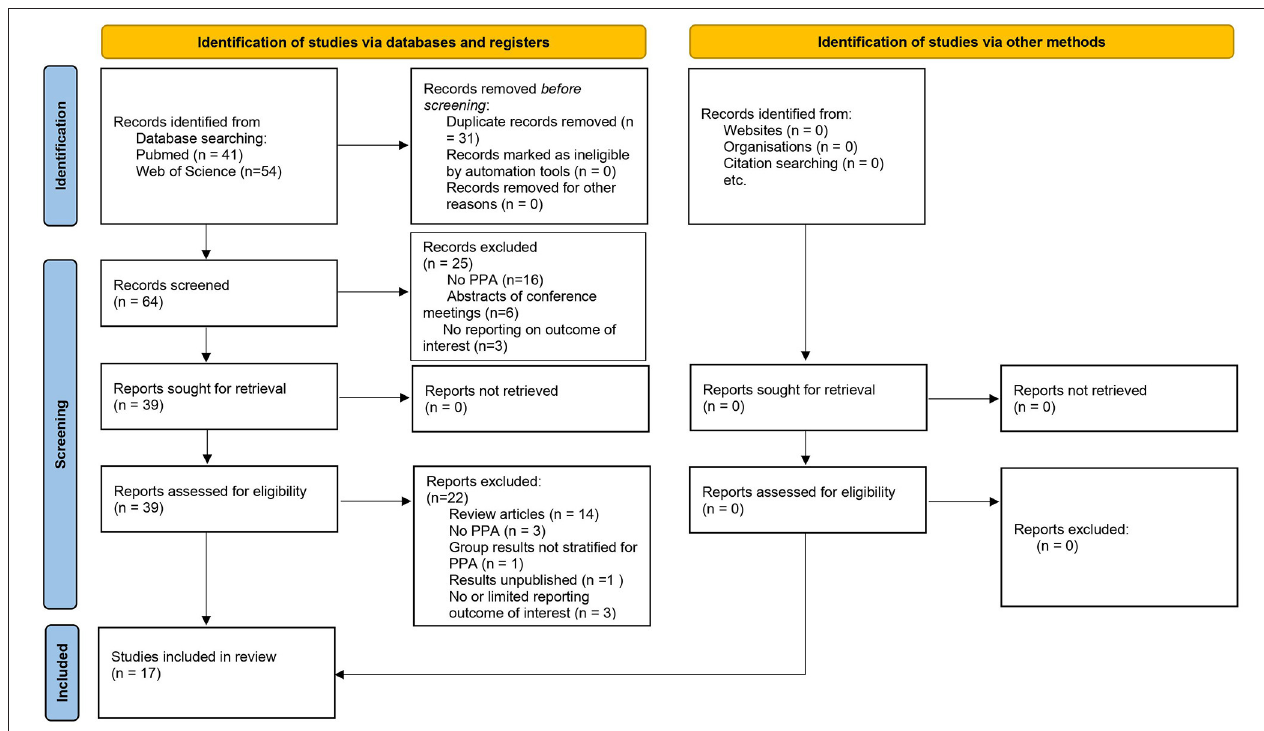
FIGURE 1 | The preferred reporting items for systematic reviews and meta-analyses (PRISMA) diagram of records identified, included, and